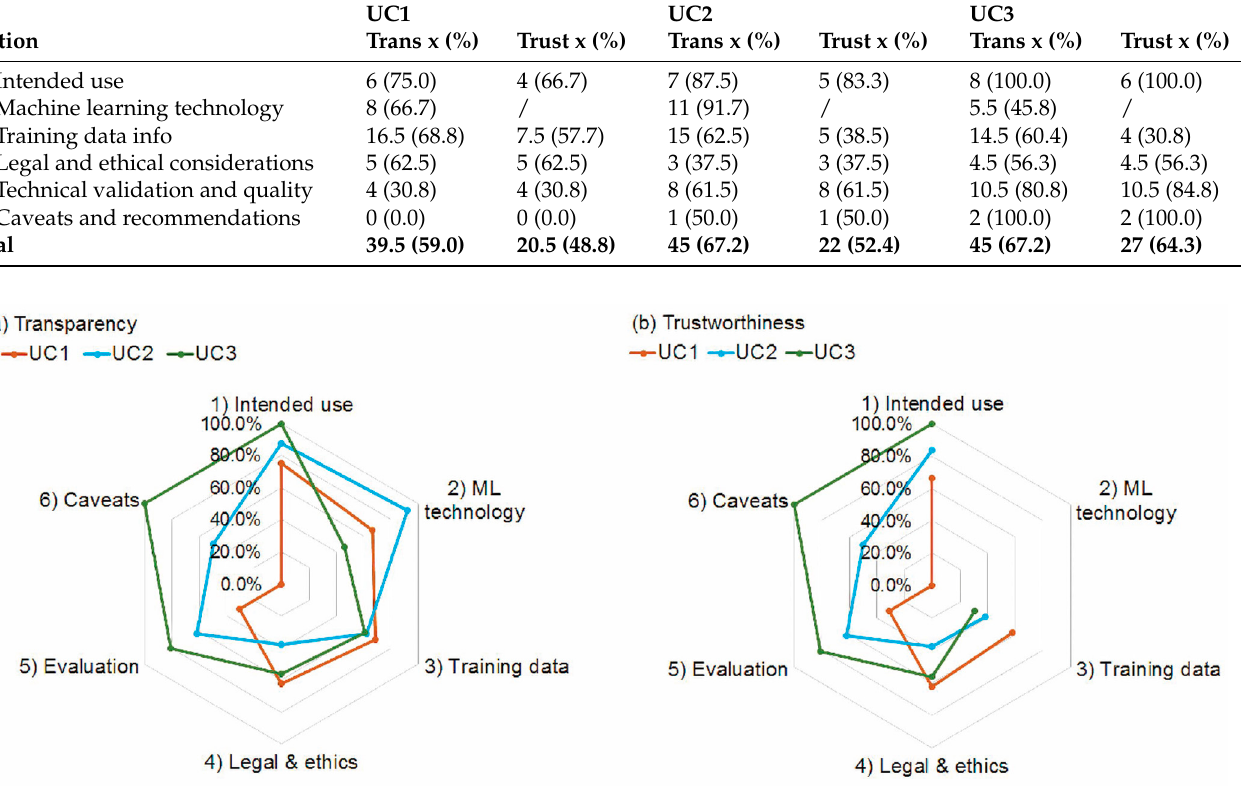
Figure 1. Relative transparency ( a ) and trustworthiness ( b ) scores achieved by use cases (UC) 1–3 in sections (1) Intended use, Section (2) Implemented Machine Learning (ML) technology, Section (3) Training data info, Section (4) Legal and ethical considerations, Section (5) Technical validation and quality, and Section (6) Caveats and recommendations for